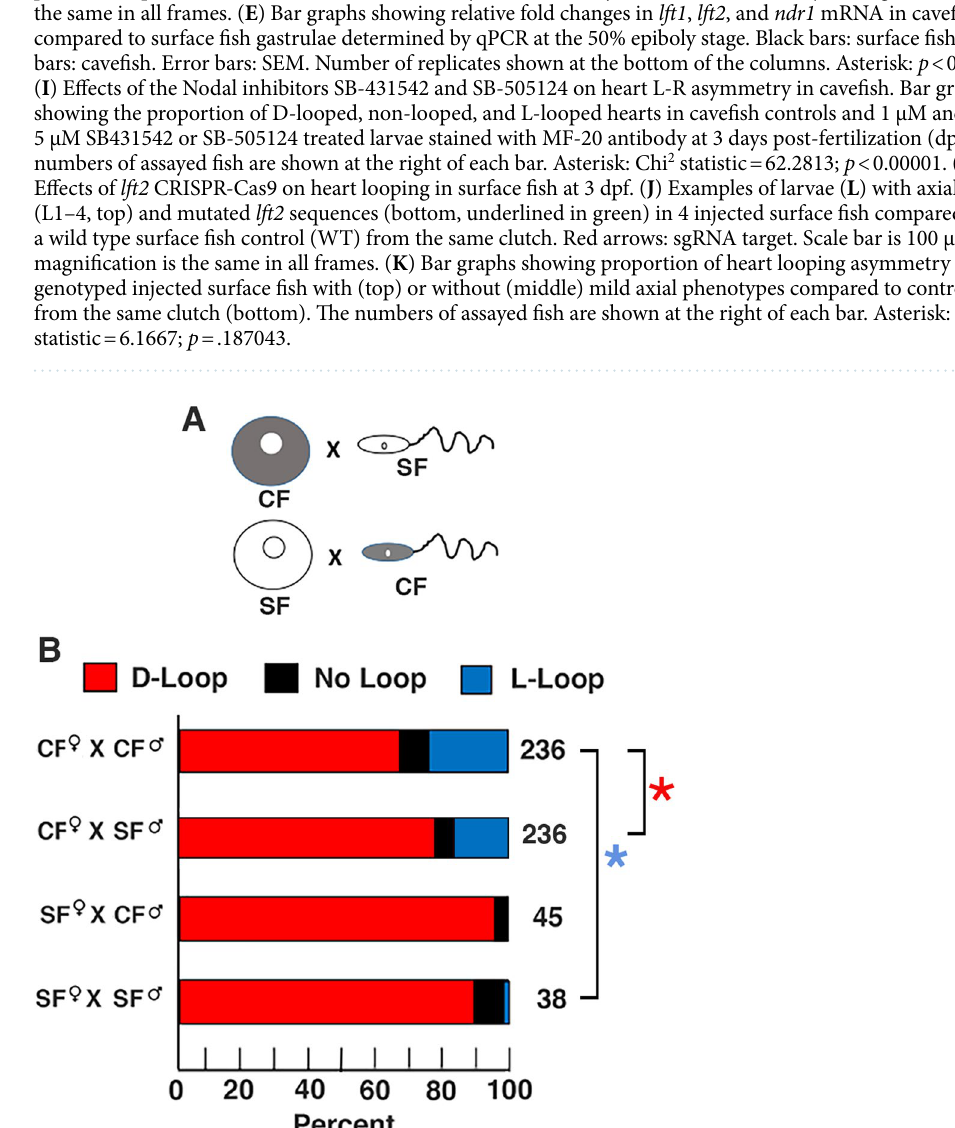
Figure 6. The influence of maternal genetic effects on heart L-R asymmetry. ( A ) Reciprocal crosses between surface fish (SF) and cavefish (CF) gametes in both directions were used to assay for maternal genetic effects. ( B ) Bar graphs showing the percentage of heart looping types in the F1 progeny of CF × CF (top row), CF female × SF male (second from top row), SF female × CF male (second from bottom row), and SF × SF (bottom row) crosses. The number of larvae analyzed are indicated at the right of each bar. Blue asterisk: Chi 2 statistic (all crosses) = 26.7158; p = .000164. Red asterisk. Chi 2 statistic (CF × CF and CF × SF crosses) = 7.007; p =